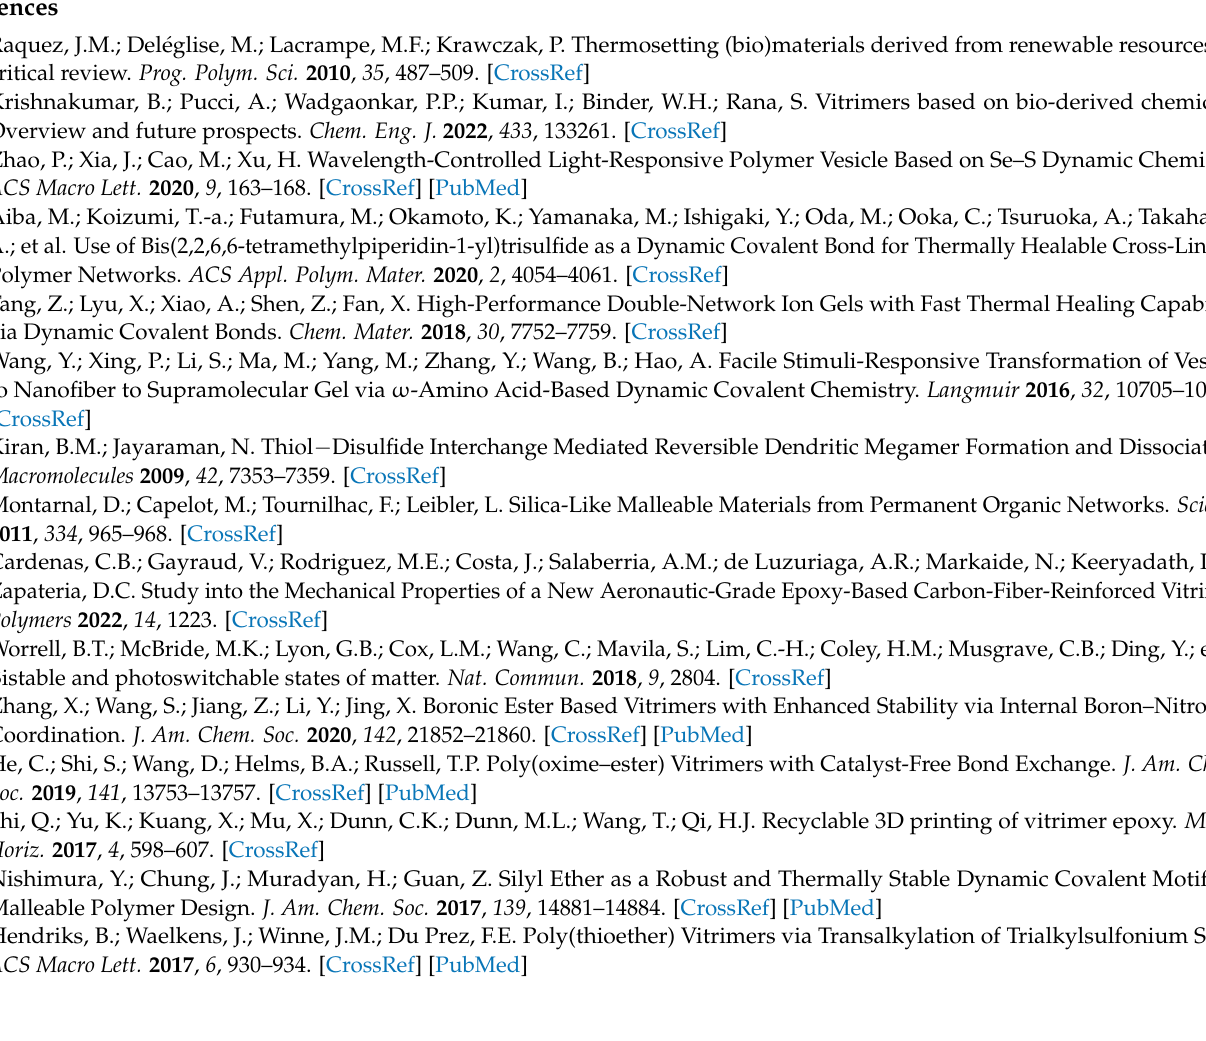
Figure S7: 13 C NMR Spectrum of pentaerythritol tetra(3-mercaptacetoacetate) (PETMPA) (100 MHz, CDCl 3 , 77